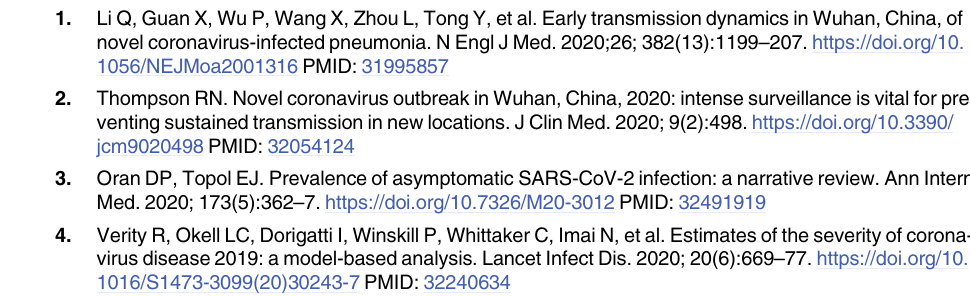
S1 Table. Summary of the data used in our analysis. S2 Table. Estimated parameters and initial values for each